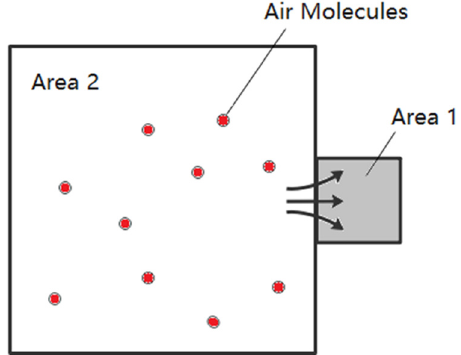
Figure 6: Section of nanochannels. This diagram demonstrates that air molecules also pass through tiny tubes as they move from area 2 to area